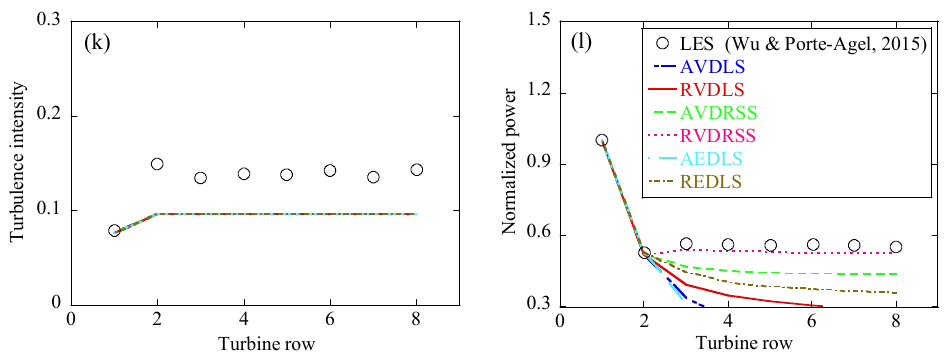
Figure 11. Comparisons of velocity deficit, turbulence intensity and power generations between simulations and predictions by: ( a – c ) the No. 46 combined wake model; ( d – f ) the No. 47 combined wake model; ( g – i ) the No. 52 combined wake model; ( j – l ) the No. 53 combined wake model; with different superposition approaches.